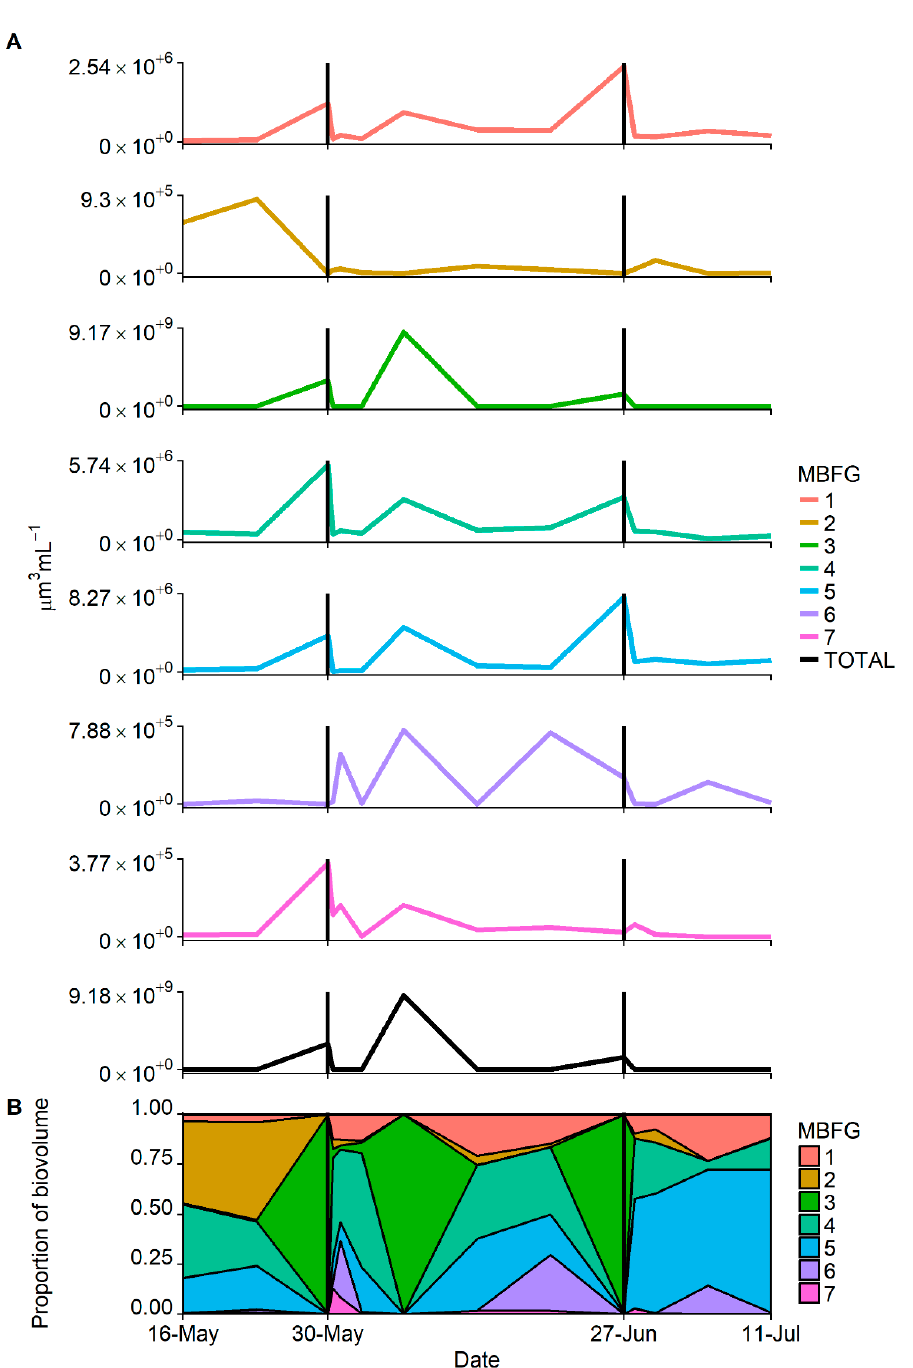
Figure 7. ( A ) Biovolume of morphology-based functional groups (MBFGs) 1–7 and total biovolume of phytoplankton at the F max depth in FCR during the monitoring period. Solid vertical lines denote mixing events. ( B ) Proportional biovolume of the seven MBFGs in Falling Creek Reservoir at the depth of chlorophyll maximum, highlighting shifts in community dominance. The seven MBFGs are: 1—small, high SA:V cells; 2—small siliceous flagellates; 3—large, high SA:V filaments; 4—medium-sized, unspecialized cells; 5—medium/large flagellates; 6—non-flagellated siliceous cells; and 7—large, mucilaginous, low SA:V colonies. Mixing events are denoted by vertical black lines.